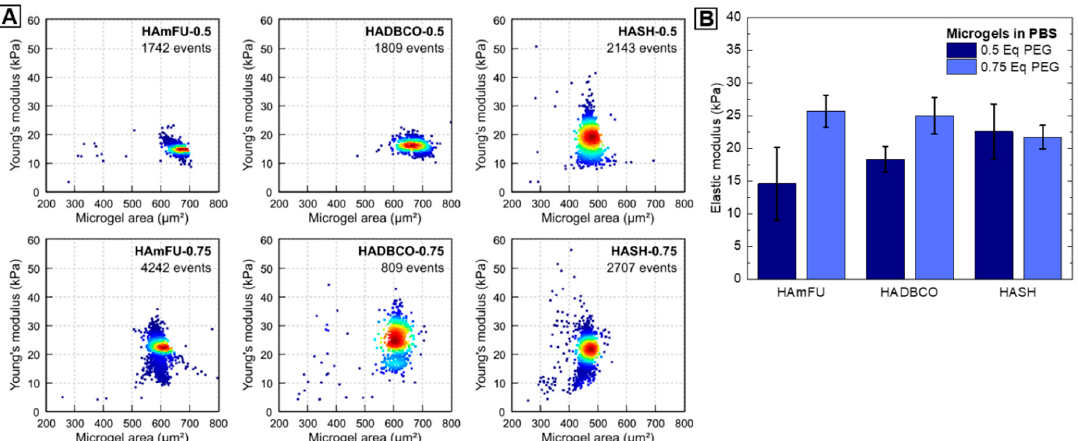
Figure 7. Mechanical characterization of microgels. ( A ) Exemplary Young’s modulus versus microgel area scatter plots for HAmFU-, HADBCO-, and HASH-microgels at PEG-crosslinker concentrations of 0.5 Eq and 0.75 Eq, respectively. Measurements are performed using RT-DC inside a 300 µm long channel of 40 × 40 µm cross-section and at a flow rate of 0.60 µL s − 1 . ( B ) Corresponding statistical analysis of three microgel replicates per microgel species (mean ± SEM).